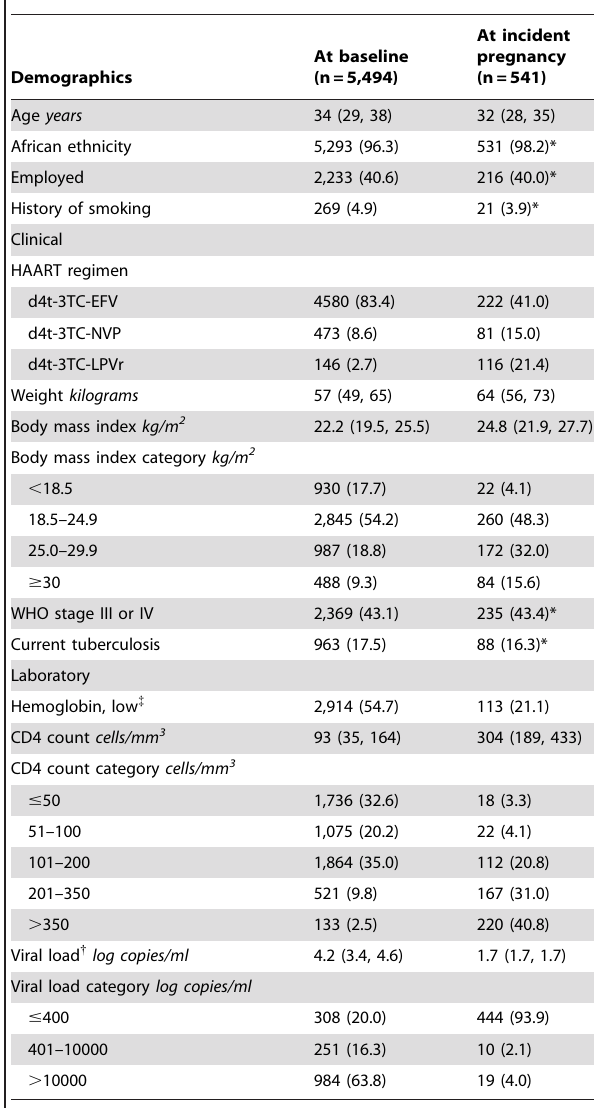
Table 1. Characteristics of 5,494 women at time of HAART initiation, and a subpopulation of 541 of those women at time of incident pregnancy, in Johannesburg, South Africa from